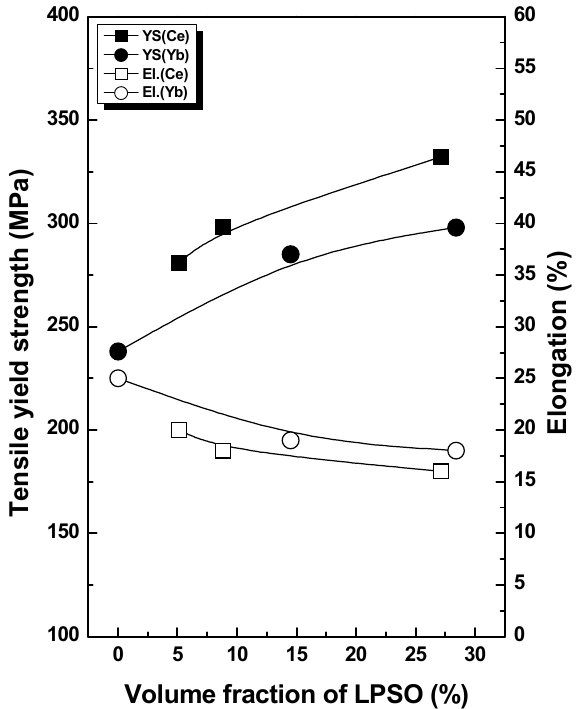
Figure 12. Variation in the tensile yield strength with the volume fraction of the LPSO phases. As shown in Figure 9, the worked Mg grains that existed in the Mg 88.5 Zn 5 Y 5 Ce 1.5 and Mg 88.5 Zn 5 Y 6.5 alloys disappeared after the heat treatment at 400 °C for 1 h. This result indicated the presence of deformed storage energy inside the grains after